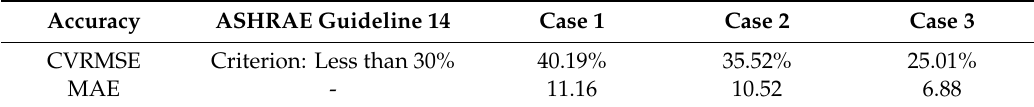
Figure 13. Comparison of prediction accuracy of all three cases. Table 8. Comparison of prediction accuracy of all three cases with the American Society of Heating, Refrigerating and Air-Conditioning Engineers (ASHRAE) Guideline 14.